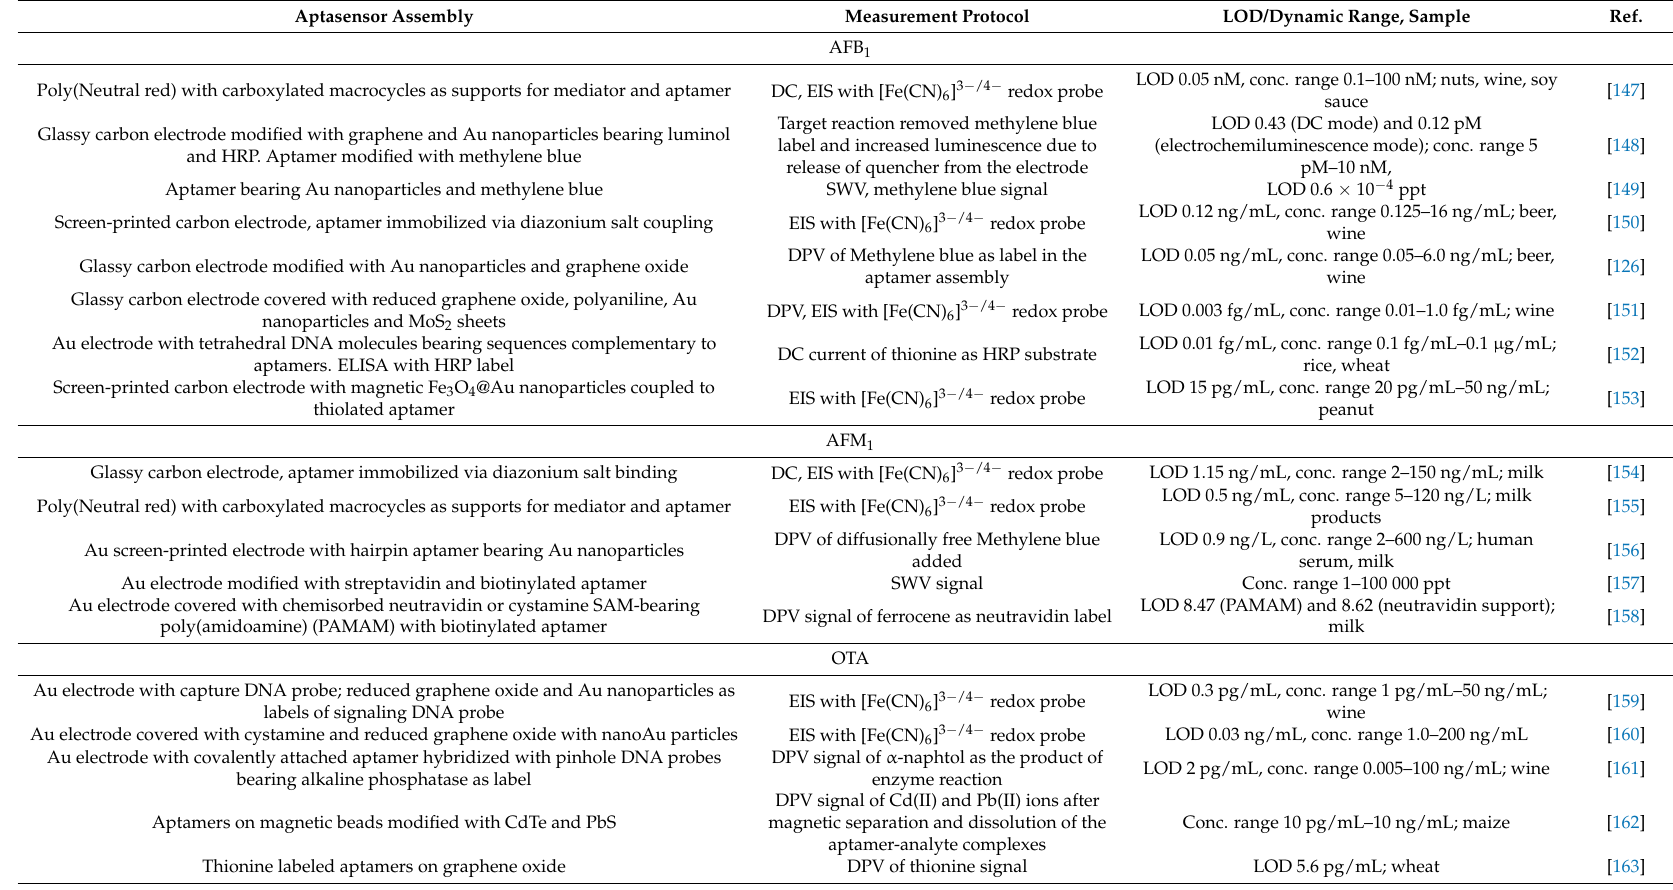
Table 4. Electrochemical aptasensors for mycotoxin determination